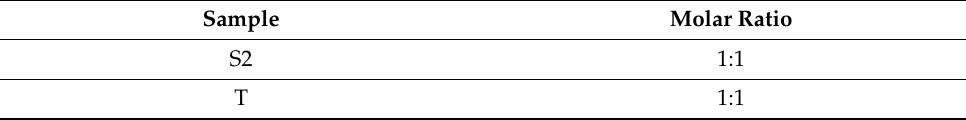
Table 6. Coating ratios between sample and HA-Chol 1.5